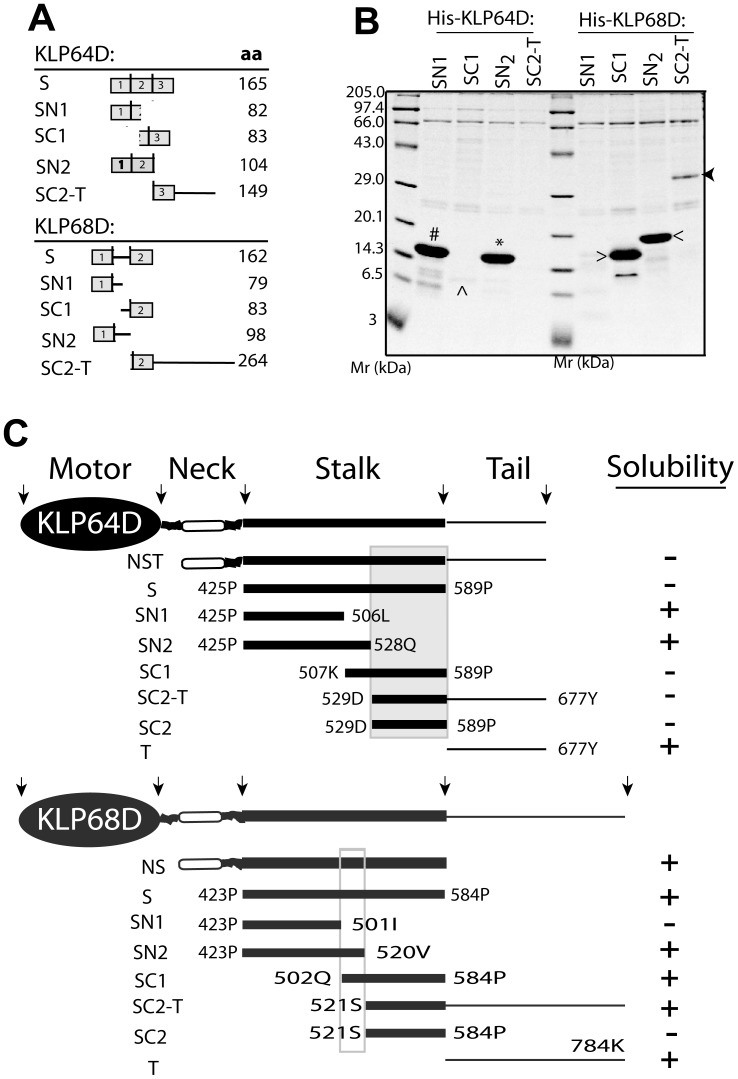
Expression and purification of the recombinant kinesin-II stalk fragments indicates complementary segmental stabilities in the stalk domains.A) Schematic illustrates the extents and corresponding lengths in amino acids (indicated under ‘aa’ on the right margin) of different stalk fragments cloned (Table S1). B) Equal amounts of extracts from E. coli expressing different recombinant stalk fragments were purified through Ni-NTA chromatography. The eluates were separated by SDS-PAGE and Coomassie stained to reveal the contents. Prominent bands of sizes expected for His-KLP64D-SN1 (#) and –SN2 (*), His-KLP68D-SC1 (>) and –SN2 (<), a faint His-KLP64D-SC1 (∧) band and a relatively weak His-KLP68D-SC2-T band (arrowhead) are marked on the figure. C) Schematic summary of the stalk fragment-stability. Grey box highlight the region imparting instability to KLP64DS and the open box indicates the region imparting stability to the KLP68DS. Abbreviations: NST – neck stalk tail, NS – neck stalk, S – stalk, SN1– N-terminal half of stalk, SN2– N-terminal 2/3rd stalk, SC1– C-terminal half of stalk, SC2-T – C-terminal 1/3rd stalk and tail, SC2– C-terminal 1/3rd stalk, T- tail.